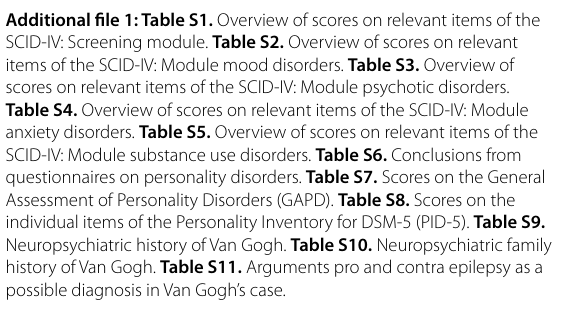
Additional file 1: Table S1. Overview of scores on relevant items of the SCID-IV: Screening module. Table S2. Overview of scores on relevant items of the SCID-IV: Module mood disorders. Table S3. Overview of scores on relevant items of the SCID-IV: Module psychotic disorders. Table S4. Overview of scores on relevant items of the SCID-IV: Module anxiety disorders. Table S5. Overview of scores on relevant items of the SCID-IV: Module substance use disorders. Table S6. Conclusions from questionnaires on personality disorders. Table S7. Scores on the General Assessment of Personality Disorders (GAPD). Table S8. Scores on the individual items of the Personality Inventory for DSM-5 (PID-5). Table S9. Neuropsychiatric history of Van Gogh. Table S10. Neuropsychiatric family history of Van Gogh. Table S11. Arguments pro and contra epilepsy as a possible diagnosis in Van Gogh’s case.